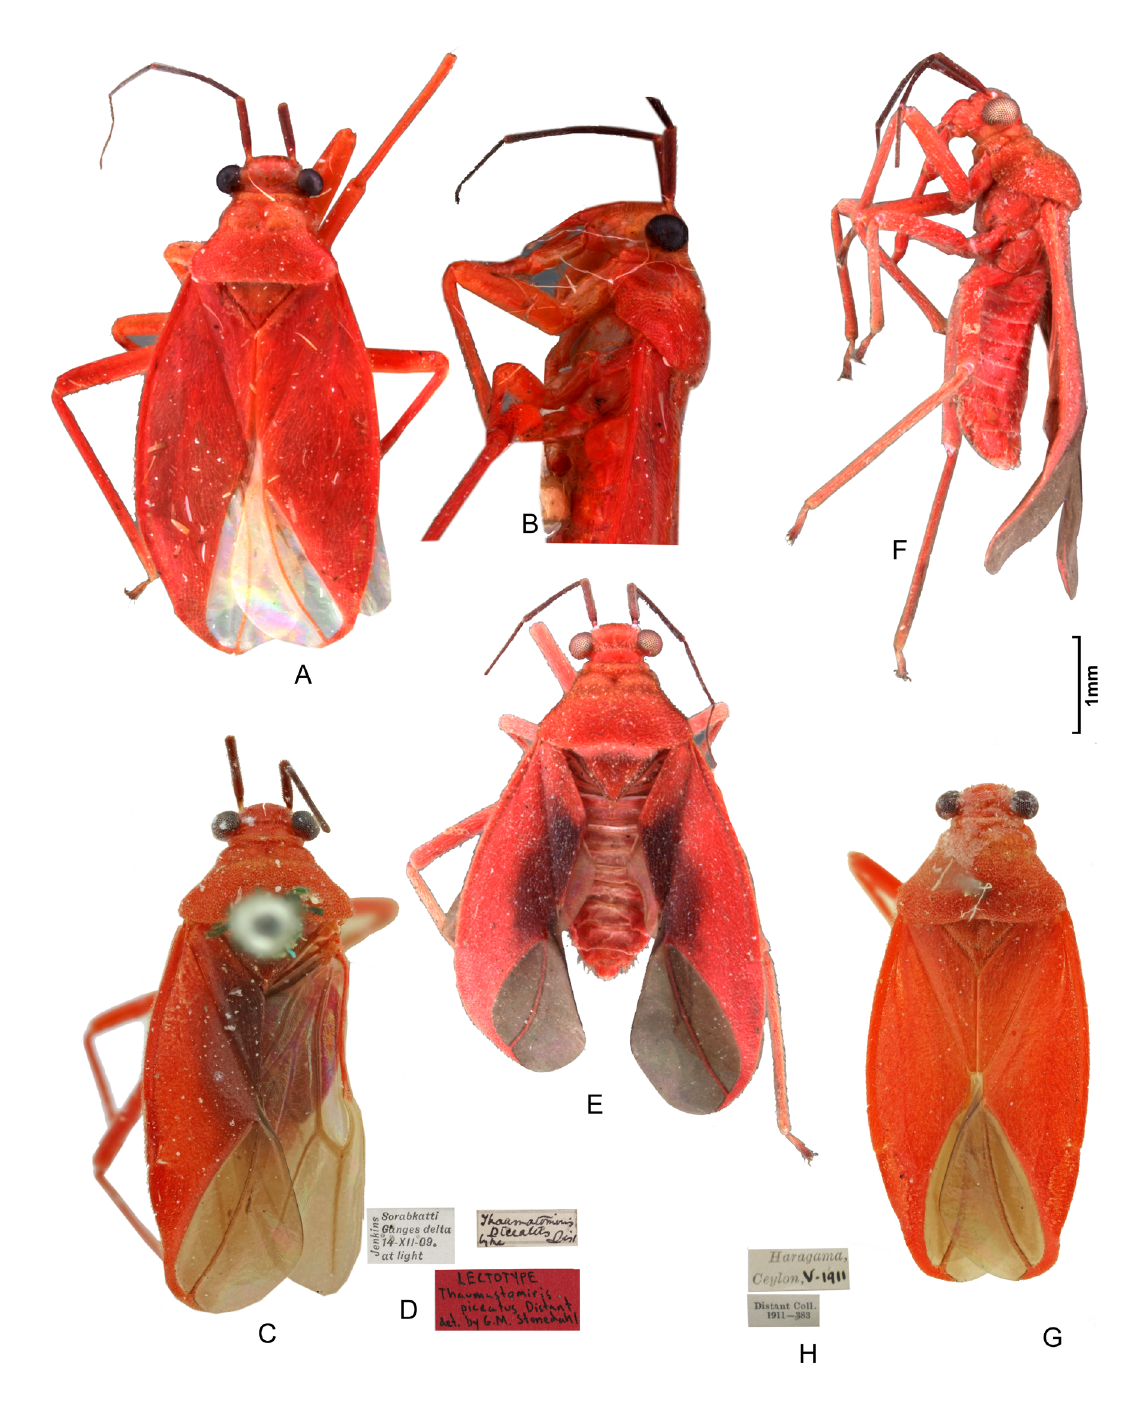
Fig. 10. Dorsal view and label data of Thaumastomiris spp. A–B . Thaumastomiris philippinensis Hsiao, 1944, ♀, holotype, USNM. C–D . Thaumastomiris piceatus Distant, 1911, ♂, lectotype, NHM. E–F . Thaumastomiris piceatus Distant, 1910, ♀, specimen from Burma, USNM. G–H . Thaumastomiris sanguinalis Kirkaldy, 1902, ♀, specimen from Sri Lanka,